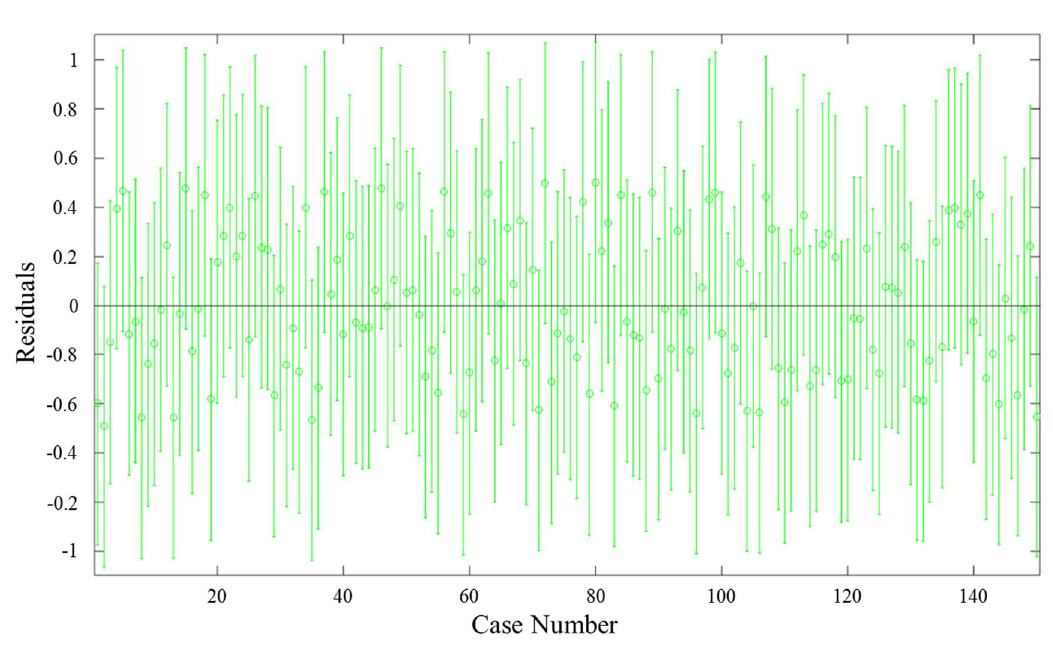
Figure 1. Map of chiller model fitting residual.